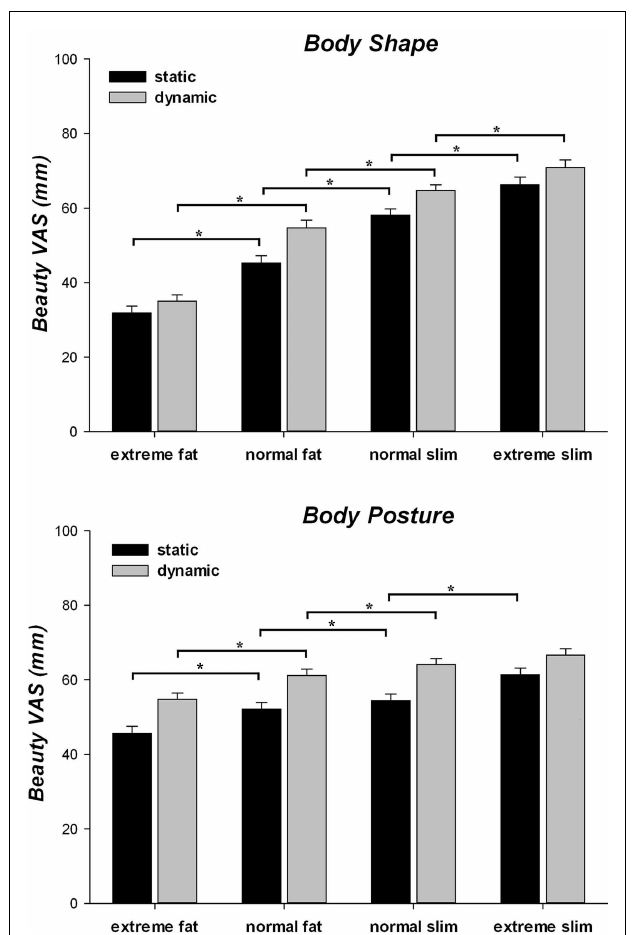
FIGURE 3 | Mean and standard error of mean for beauty subjective rating of human models as a function of body shape and posture block, implied motion (static/dynamic) along the four categories of body weight (extreme fat/normal fat/normal slim/extreme slim). * p <